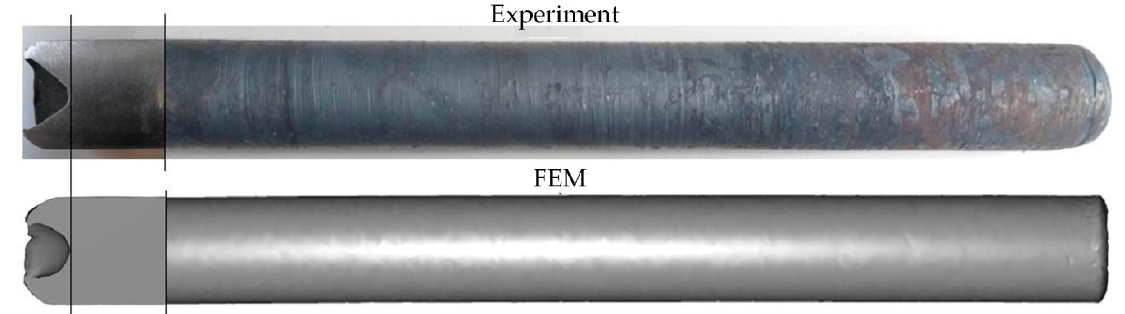
Figure 17. Shape of the rods after the second stage of rolling, with cavities visible on the end faces.